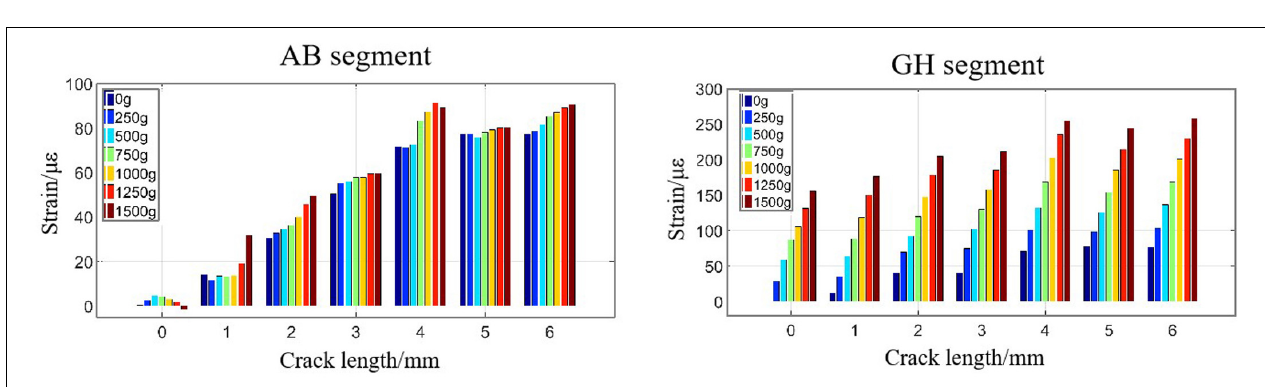
FIGURE 12 | The effect of load and crack length on the strain of the distributed optical fiber segments (AB, GH) near the